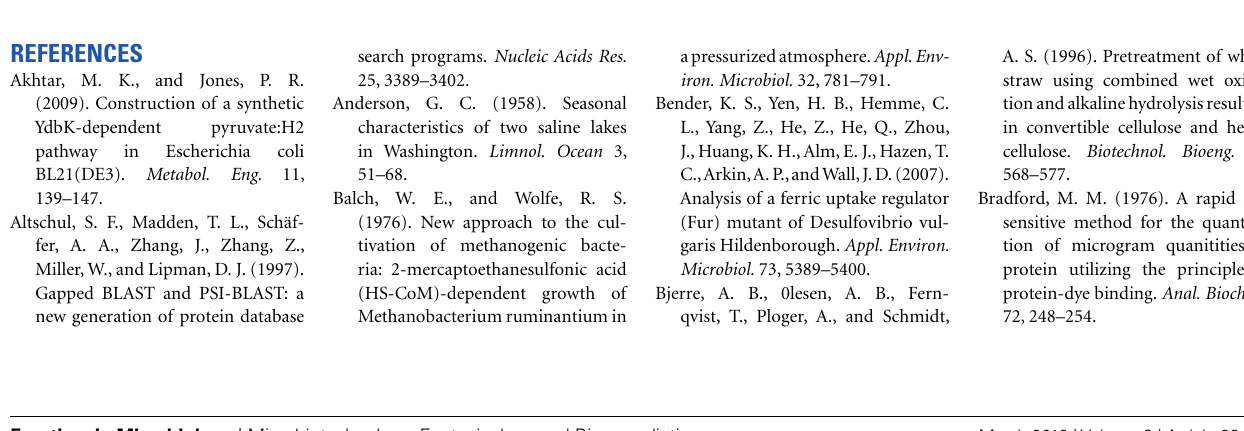
values increased by the end of the incubation (black bar), with the highest ratios of protein increase ( (cid:6) ) at lower temperatures. Fed-batch bioreactor culture of H. hydrogeniformans (E) degraded switchgrass hydrolysate ( Δ ) with • the concomitant increase in optical density ( (cid:6) ), acetate ( (cid:6) ), and formate ( (cid:2) ). ), or 170˚C (F) The (H 2) ( (cid:3) ) increased until switchgrass hydrolysate exhaustion while the • peak H 2 productivity ( ) peaked at a slightly earlier time (Zhao et al.,